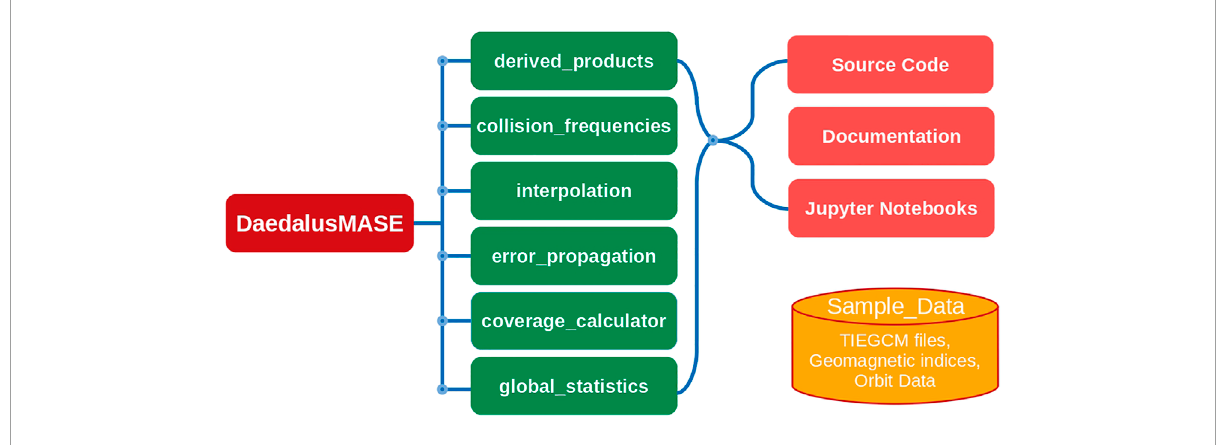
FIGURE 1 Overiview of the modules and structure of the Daedalus MASE repository.